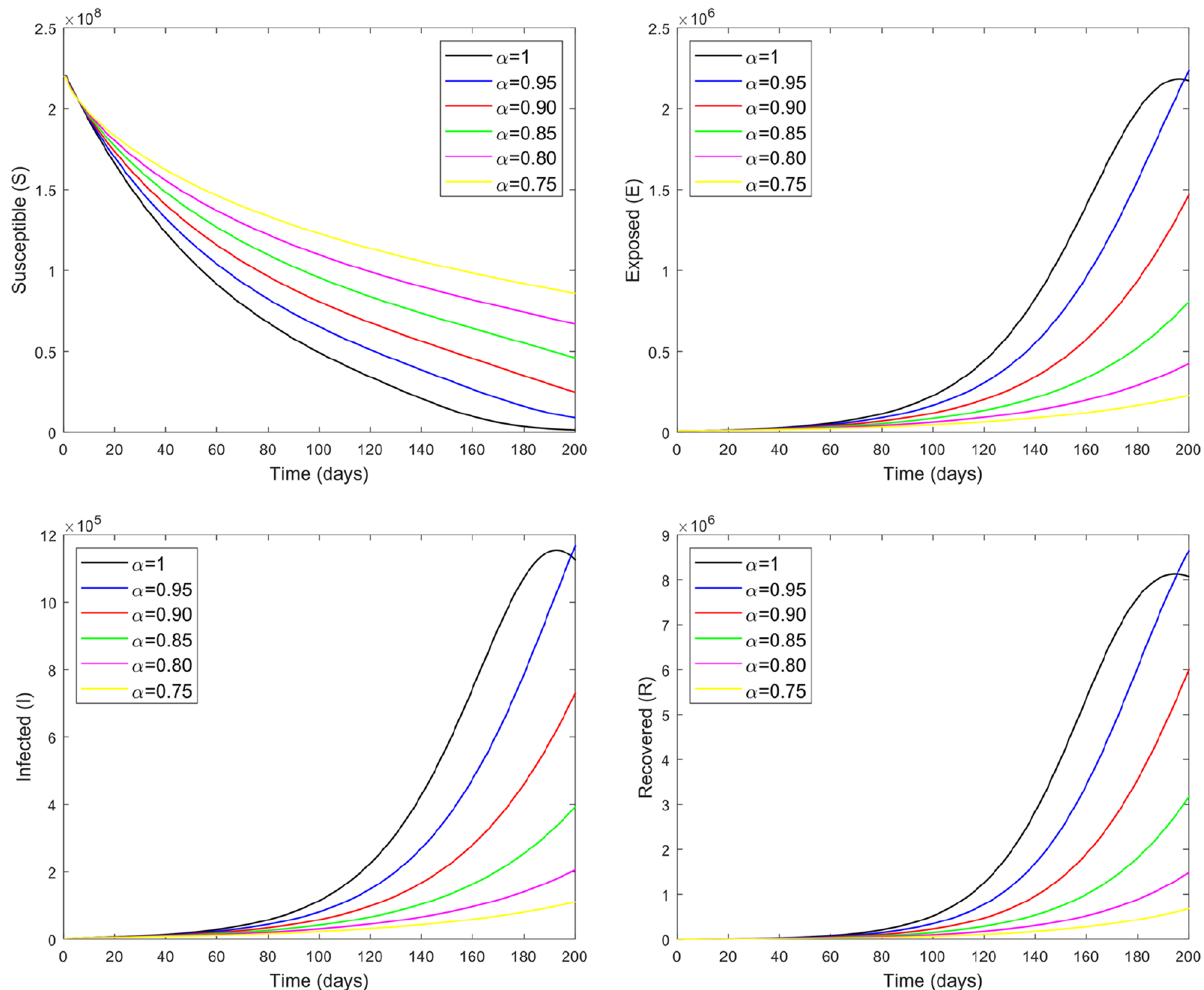
Figure 8. The dynamics of COVID-19 in different classes with different values of fractional parameter α